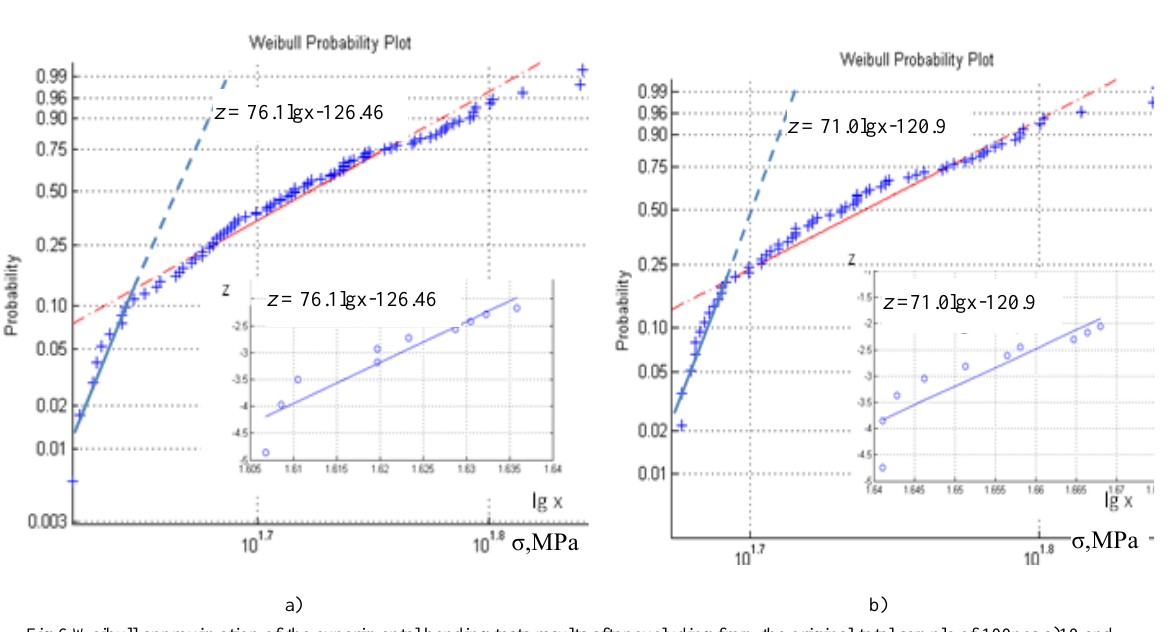
Fig.6 Weibull approximation of the experimental bending tests results after excluding from the original total sample of 100pcs a)10 and b) 20 minimum